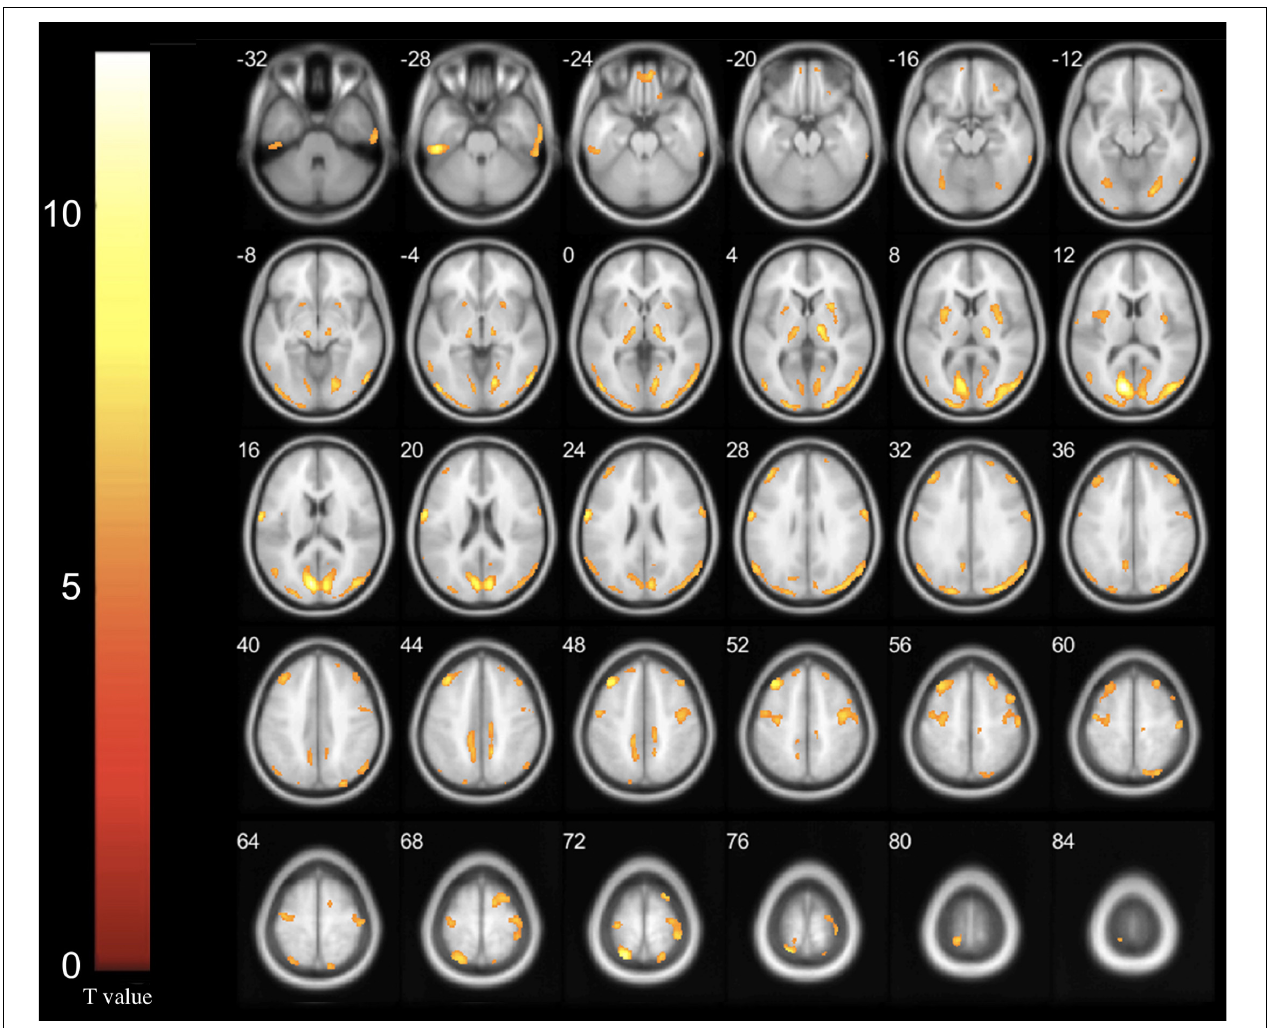
FIGURE 1 | Increased glucose metabolism regions in Meige syndrome in 6 months after STN-DBS surgery ( P < 0.001). In the left hemisphere, hypermetabolism was found in the occipital lobe, superior parietal gyrus, postcentral gyrus and thalamus. In the right hemisphere, hypermetabolism was found in the lentiform nucleus, precuneus and precentral gyrus. In addition, the bilateral inferior temporal gyrus and middle frontal gyrus exhibited glucose hypermetabolism. (Cluster size > 50 voxels. The color bar indicates the